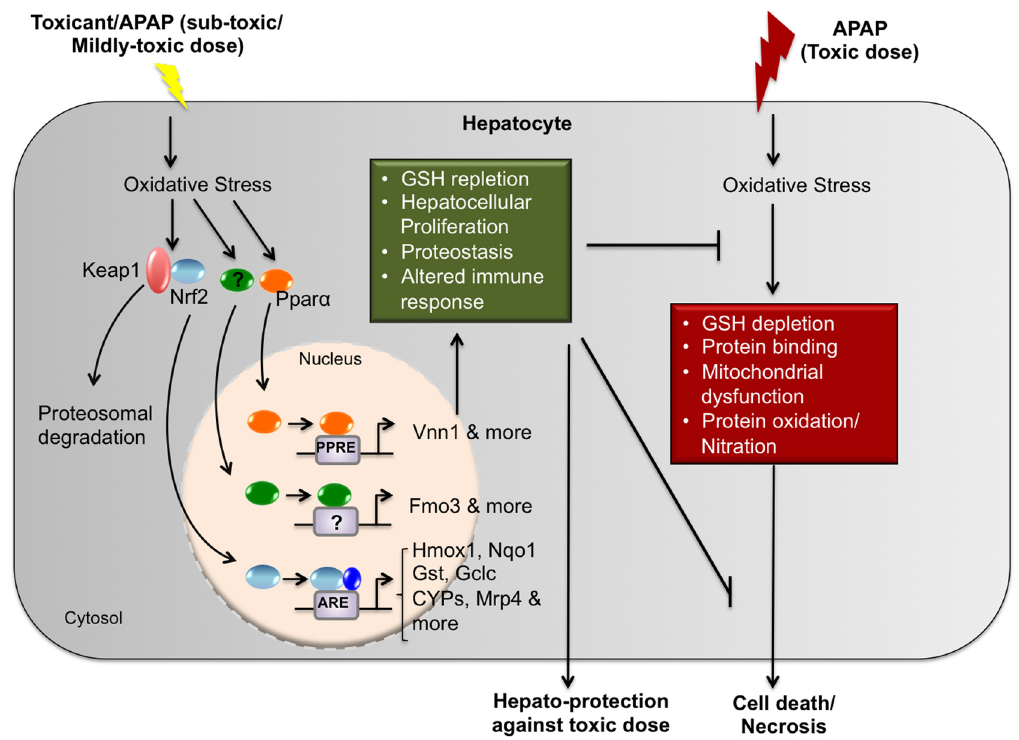
Figure 1. Mechanism of autoprotection/heteroprotection in the hepatocyte. In response to a toxic dose of acetaminophen (APAP), oxidative stress ensues. Resulting molecular events include those depicted here: glutathione (GSH) depletion, protein binding/protein adduct formation, mitochondrial dysfunction, and protein oxidation/nitration leading to cellular death or necrosis. In autoprotection/heteroprotection, a subtoxic or a mildly toxic dose of toxicant (APAP or clofibrate) results in activation of various transcription factors (Nrf2, PPAR α , etc.), resulting in the transcription of cytoprotective genes that play a role in adaptive responses. These adaptive responses include hepatocellular proliferation, proteostasis, enhanced expression of cytoprotective genes, and altered tissue immune responses that protect the liver against a challenge toxic dose of APAP. Abbreviations: APAP, acetaminophen; ARE, antioxidant response element; CYP, cytochrome P450; FMO3, flavin- containing monooxygenase 3; Gclc, glutamate-cysteine ligase, catalytic subunit; Gst, glutathione S-transferase; Hmox1, heme oxygenase-1; Keap1, kelch-like ECH-associated protein 1; Mrp, multidrug resistance-associated protein; Nrf2, nuclear factor (erythroid-derived 2)-like 2; Nqo1, NAD(P)H quinone dehydrogenase 1; PPAR α , peroxisome proliferator-activated receptor alpha; PPRE, peroxisome proliferator-activated receptor response element; Vnn1,